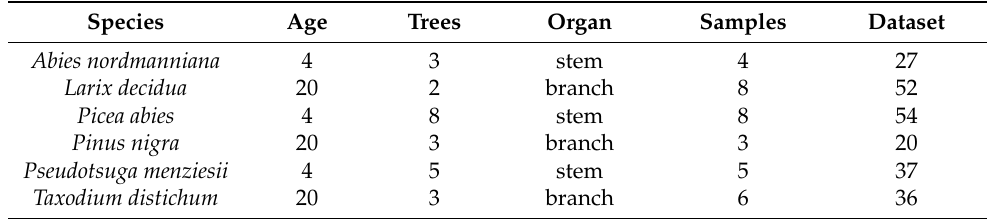
Table 1. Information on the age of the sampled trees (age), the amount of tree individuals investigated (trees), the sample numbers (samples) as well as the dataset numbers (dataset, single hydraulic measurements before and after repeated air injection). All specimens came from botanical gardens in Vienna, Austria, latitude 48 ◦ 14 (cid:48) 12” N–48 ◦ 14 (cid:48) 33” N and longitude 16 ◦ 18 (cid:48) 21” E–16 ◦ 20 (cid:48) 15” E. Species Age Trees Organ Samples Dataset Abies nordmanniana 4 3 stem 4 27 Larix decidua 20 2 branch 8 52 Picea abies 4 8 stem 8 54 Pinus nigra 20 3 branch 3 20 Pseudotsuga menziesii 4 5 stem 5 37 Taxodium distichum 20 3 branch 6